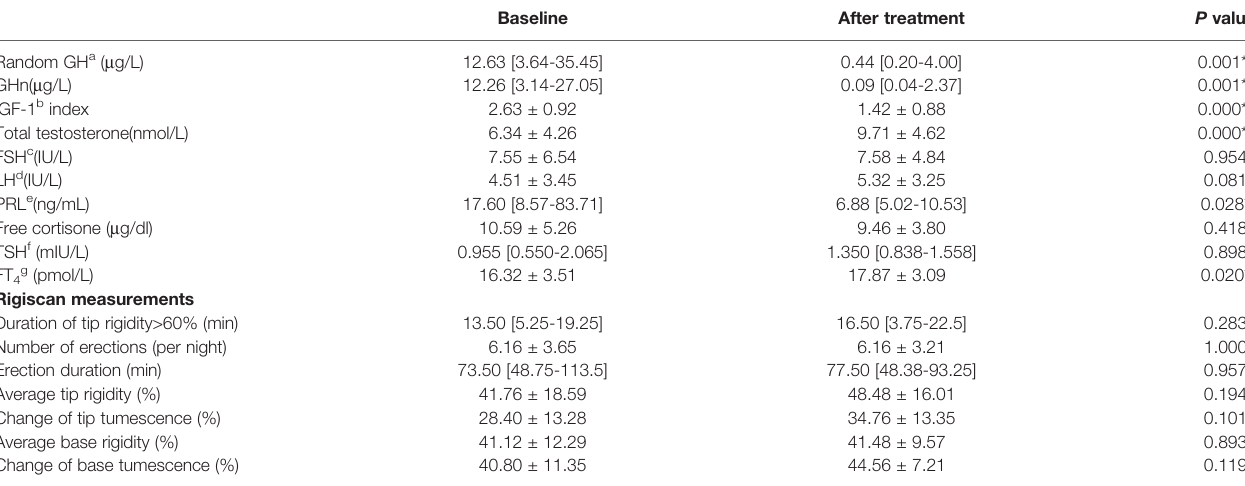
TABLE 4 | Pituitary hormones and Rigiscan measurements before and after treatment. Baseline After treatment P value